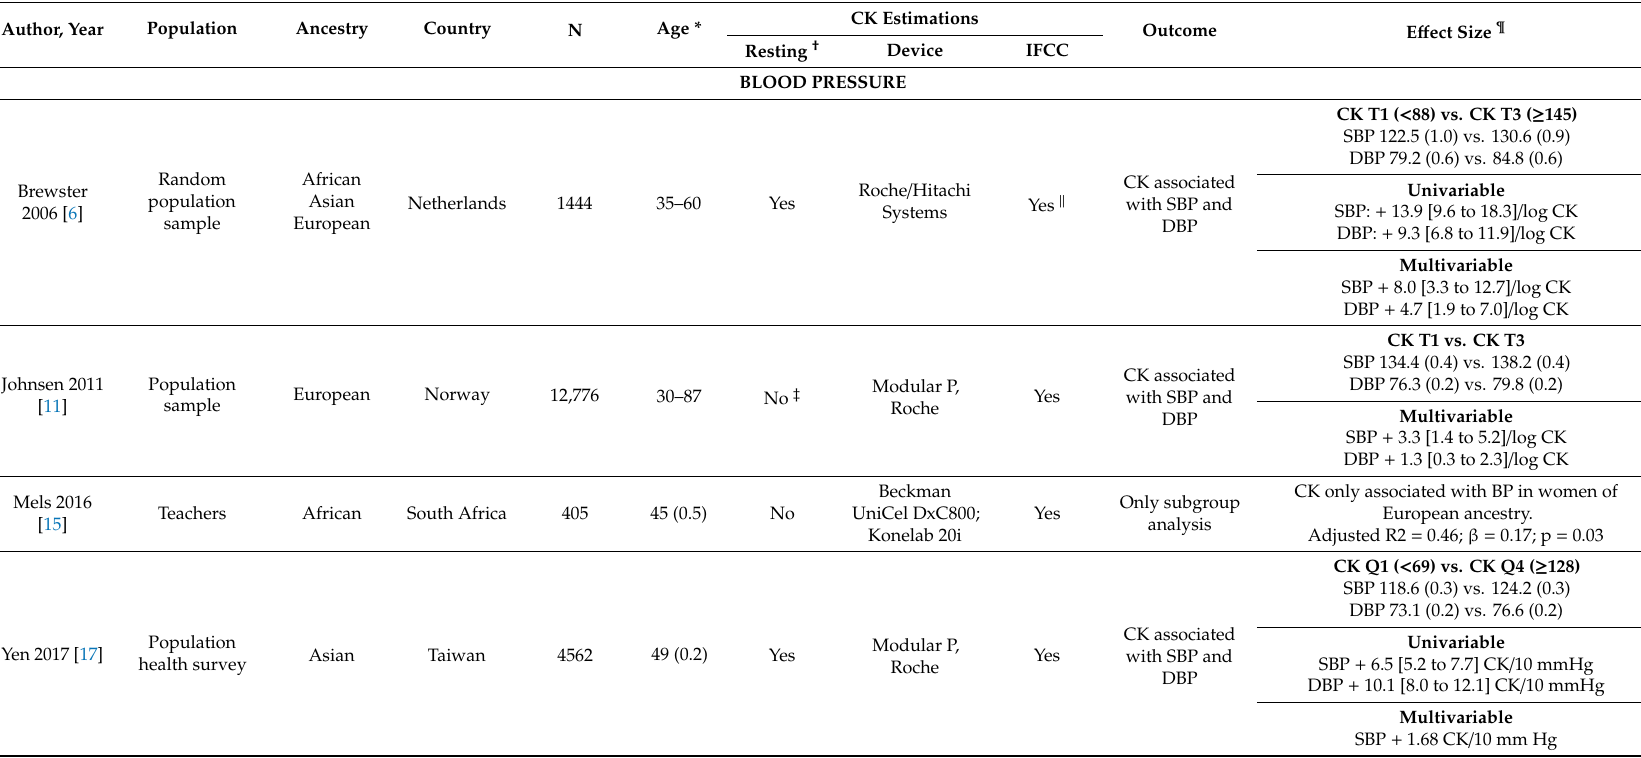
Table 1. Table of Included